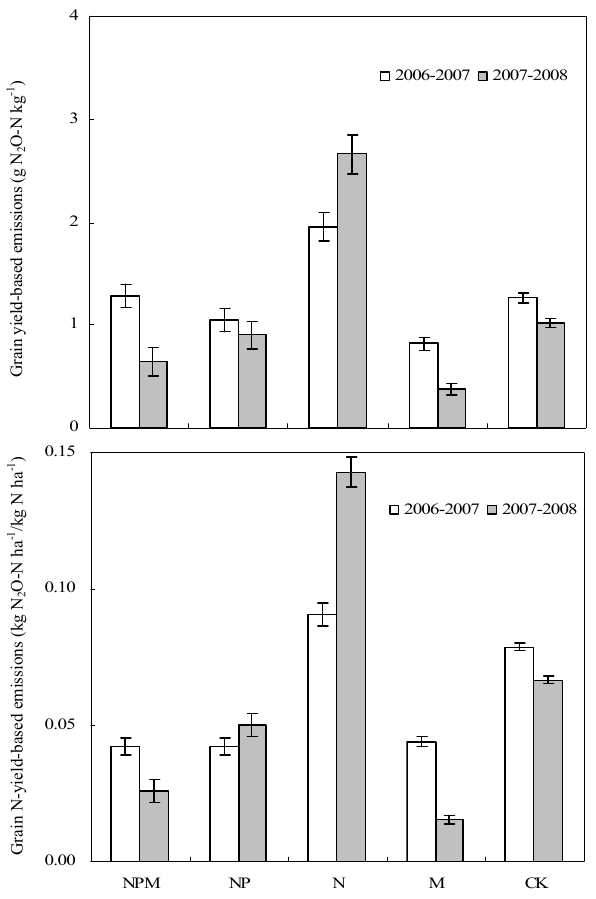
Fig. 5. Grain yield-based and grain N-yield-based N 2 O-N emis- sions for different fertilization treatments from September 2006 un- til September